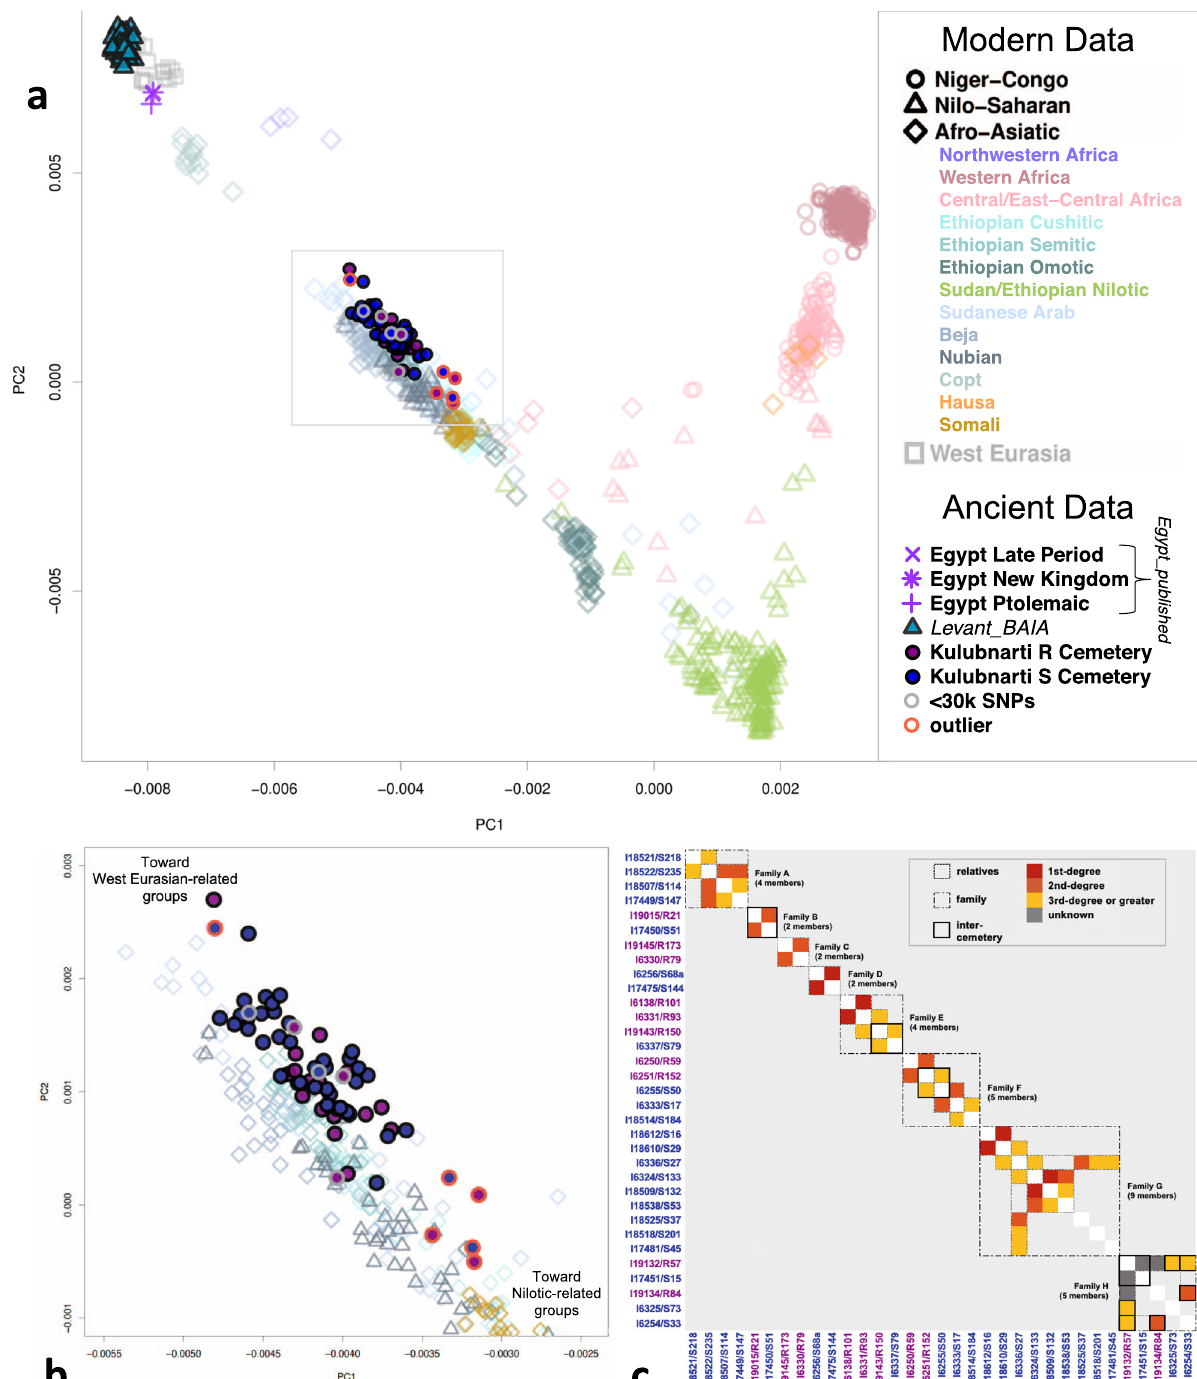
Fig. 2 Overview of population structure at Kulubnarti. a PCA with Kulubnarti Nubians projected onto axes computed using present-day African and West Eurasian populations. Individuals from Kulubnarti are shown as solid maroon or blue circles (representing R and S cemetery individuals, respectively), signi fi cant genetic outliers are outlined in orange, individuals with <30 K SNPs are outlined in gray. The area within the gray box is featured in ( b ). See Supplementary Data 4 for all individuals shown. b PCA zoomed to show the spread of the Kulubnarti Nubians along the West Eurasian – Nilo-Saharan cline. c Pairwise genetic relatedness estimates for all individuals from Kulubnarti. R and S cemetery individuals labeled in blue and maroon, respectively. Degree of relatedness is indicated by square color, with solid outlines denoting relatives, dotted outlines denoting families, and thick outlines denoting inter- cemetery relatives. Relationships labeled as ‘ unknown ’ have too few overlapping SNPs to determine degree of relatedness. Data are in